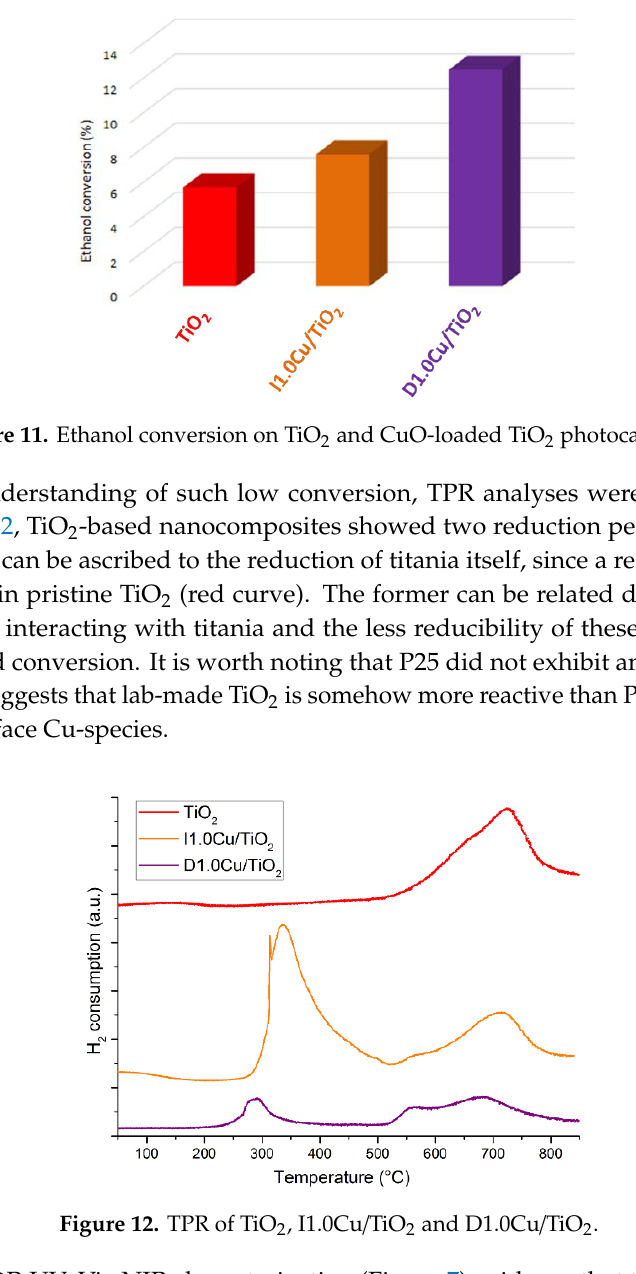
13 Figure 10. XPS Cu2p bands recorded on the three samples (starting from the bottom, samples I1.0Cu/P25, D1.0Cu/P25 and C1.0Cu/P25). Binding energy scale was corrected by the surface charging. However, Cu 2+ is very sensible to X-ray irradiation, showing a marked reduction during the spectra acquisition [70] and a decreasing of the shake-up satellite, as we also observed during analyses. Spectra reported in Figure 10 were recorded immediately after the X-ray source lighting to prevent or limit the reduction of Cu 2+ during analysis. Considering the simulation of the experimental spectra, it was possible to evidence that at the surface of sample I1.0Cu/P25 the Cu2p band is quite completely originated by copper in +2 oxidation state; in samples C1.0Cu/P25 and D1.0Cu/P25 much probably a small amount of Cu + and/or Cu 0 is also present at the sample surface (a fraction around 20% of the total copper detected). Comparing these results with TPR (Figure 5) and FTIR (Figure 8a), it can be unambiguously claimed that these Cu + /Cu 0 species are formed during X-ray irradiation. This confirms the hypothesis made from TPR analyses: the easier reducibility of the CuO allows a higher catalytic activity by converting Cu 2+ into the true active phase. CuO loading on P25 lead to a great improvement (up to twelve times) of photohydrogenation activity. The introduction technique of CuO was shown to play a crucial role on the activity enhancement, particularly the CP method afforded CuO species easier to be reduced, and with a better coverage of titania surface. This better dispersion allows an improvement of the boundaries between the co-catalyst, where the reduction occurs, and the titania surface, where the organic molecule is oxidized, thus boosting up the reaction rate [71]. Moreover, the better coverage is also supposed to passivate adsorption sites, likely to be Ti 4+ , where ethanol is likely to strongly interact with the surface as ethoxy species, hampering the dehydrogenation process. 3.2.2. Copper Oxide-TiO 2 Nanocomposite Due to its having the best observed performances of bare lab-made TiO 2 compared to P25, as shown in Section 3.1, the CuO co-catalyst was introduced onto the former by either impregnation (I1.0Cu/TiO 2 ) and CP method (D1.0Cu/TiO 2 ). As observed in Section 3.2.1., 1.0 wt% was chosen as metal loading in both method due to the better performances, while 1,3-propanediol was selected as a model ligand for the CP approach since no remarkable differences was seen by using either this molecule or citric acid.